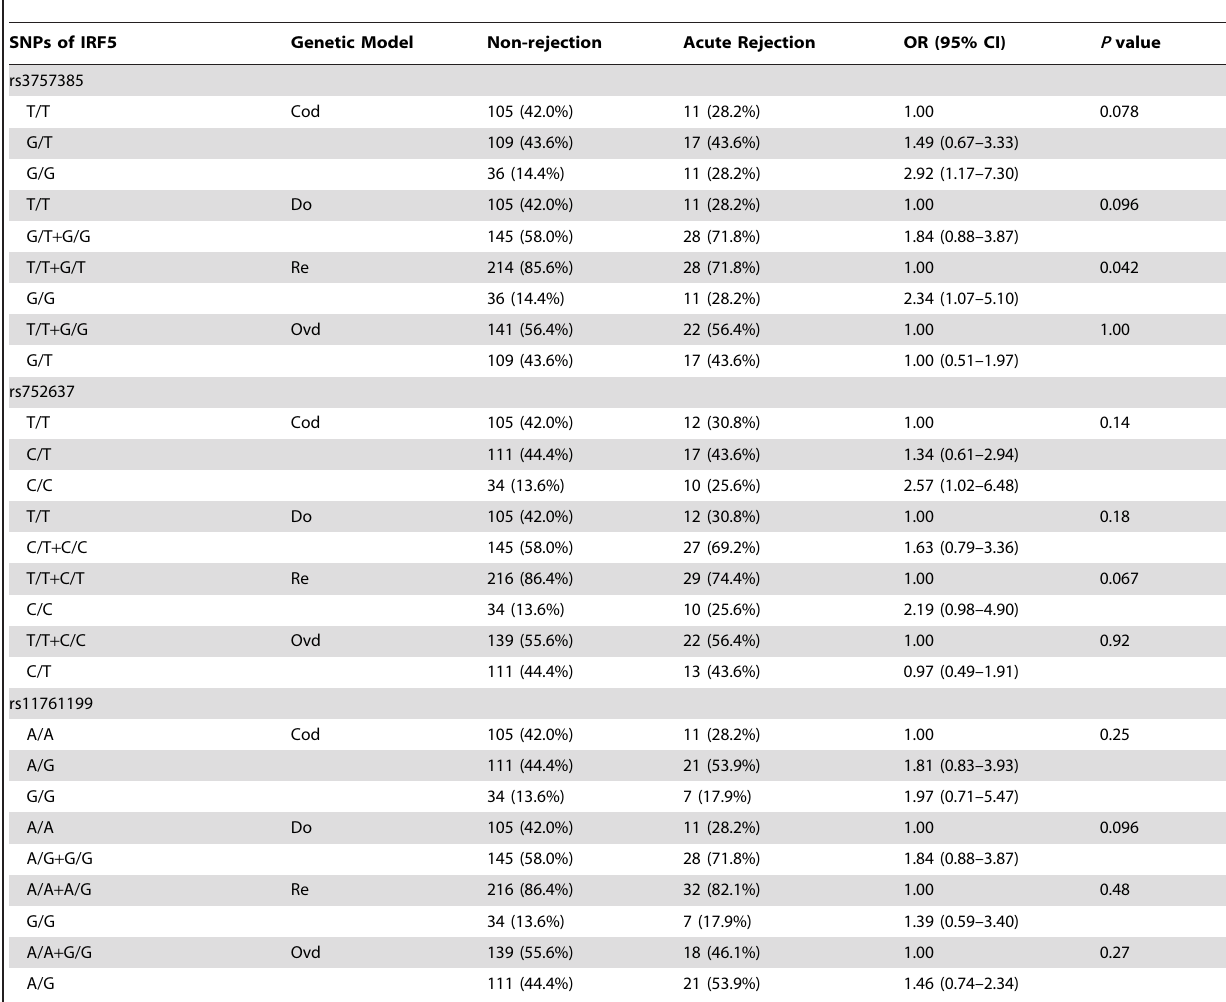
Table 2. Association of genetic polymorphism of IRF5 with acute rejection.